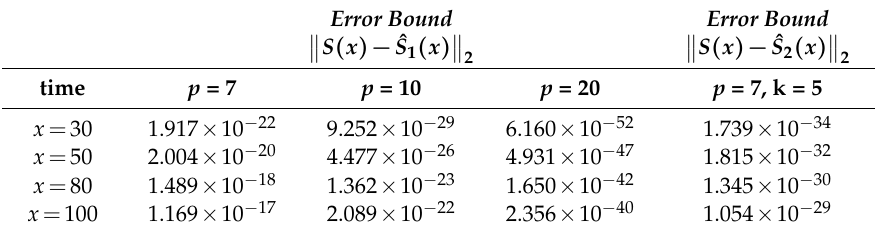
Table 2. Error bound calculated for both approximations, ˆ S 1 ( x ) and ˆ S 2 ( x ) , compared to the exact model S ( x ) in the concatenated Markov process with simulated real bladder cancer